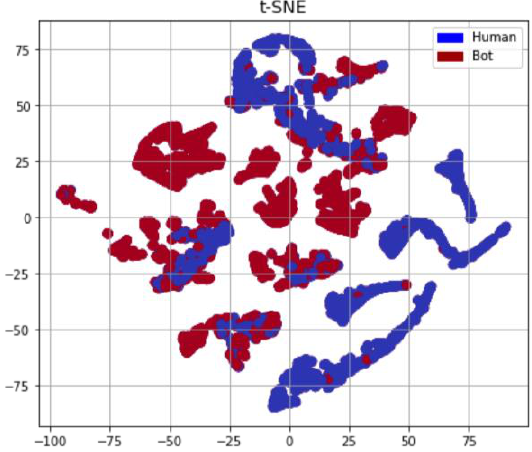
Figure 7. Visualization of SEBD results using t - SNE.